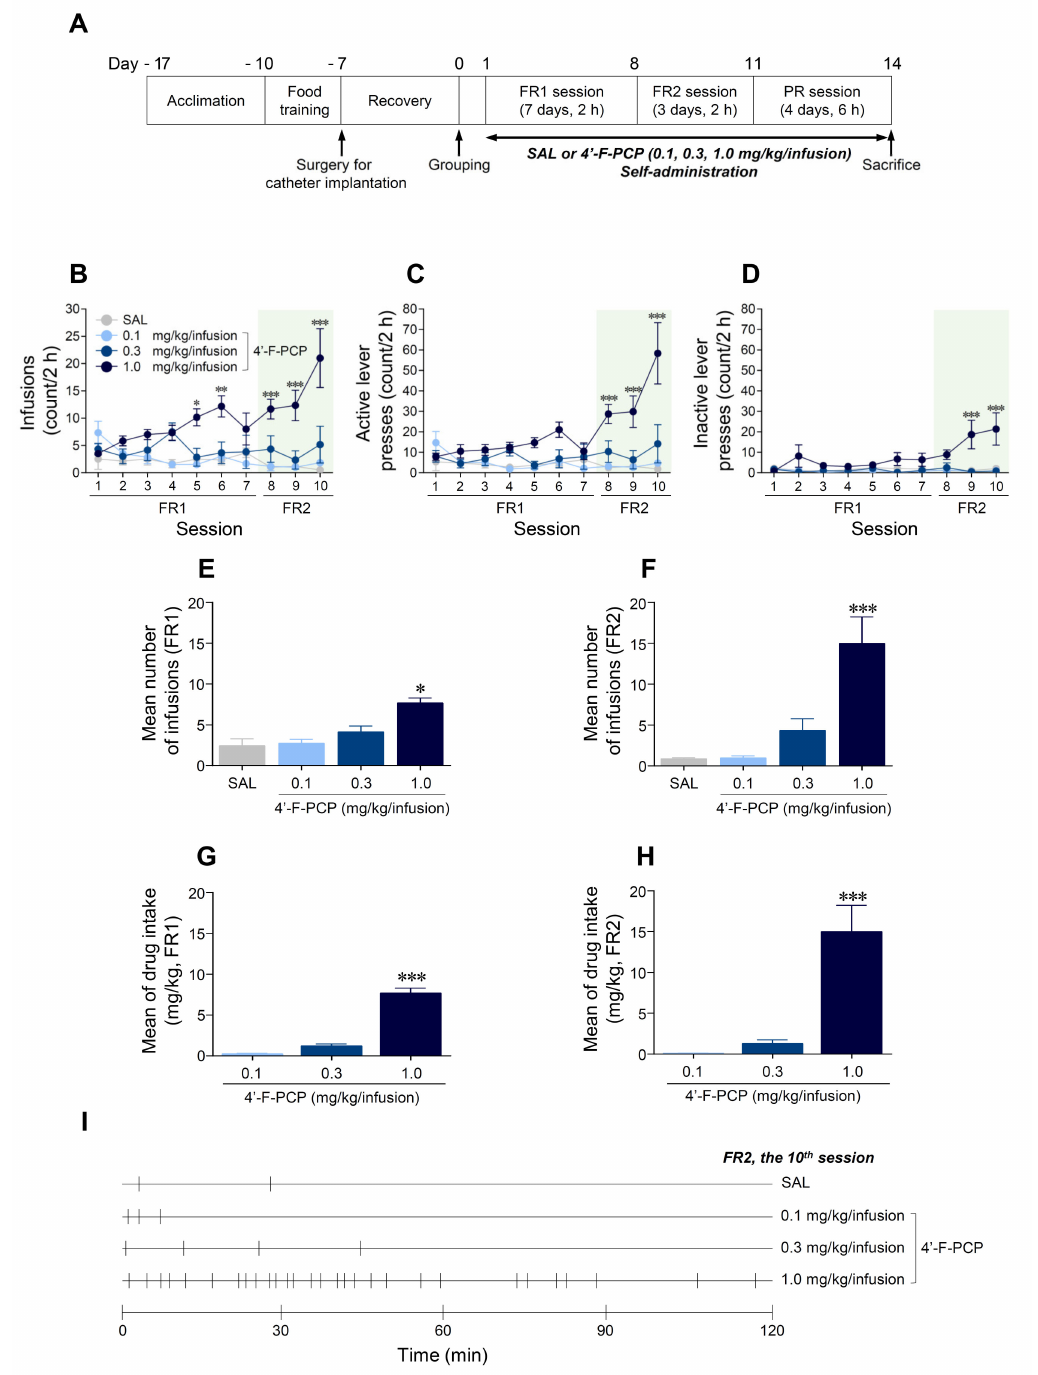
Figure 3. E ff ects of 4 (cid:48) -F-PCP on self-administration under fixed ratio (FR) schedule in rats. ( A ) Experimental timeline for 4 (cid:48) -F-PCP self-administration under FR and progressive ratio (PR) schedules of reinforcement. ( B – D ) Temporal analysis of mean number of infusions, active lever presses, and inactive lever presses during a 2 h session under FR1 and FR2 schedules. ( E , F ) Mean of total number of infusions for a 2 h session under FR1 and FR2 schedules. Asterisks *, **, and *** indicate p < 0.05, p < 0.01, and p < 0.001, respectively, vs. saline self-administered group. ( G , H ) Mean of intake amount of 4 (cid:48) -F-PCP for a 2 h session under FR1 and FR2. Asterisks *** indicate p < 0.001 vs. 0.1 and 0.3 mg / kg / infusion 4 (cid:48) -F-PCP group. ( I ) Representative hatchmarks indicate the infusion patterns of saline and 4 (cid:48) -F-PCP at the final self-administration session of FR2 schedules. SAL: saline. n = 6 per